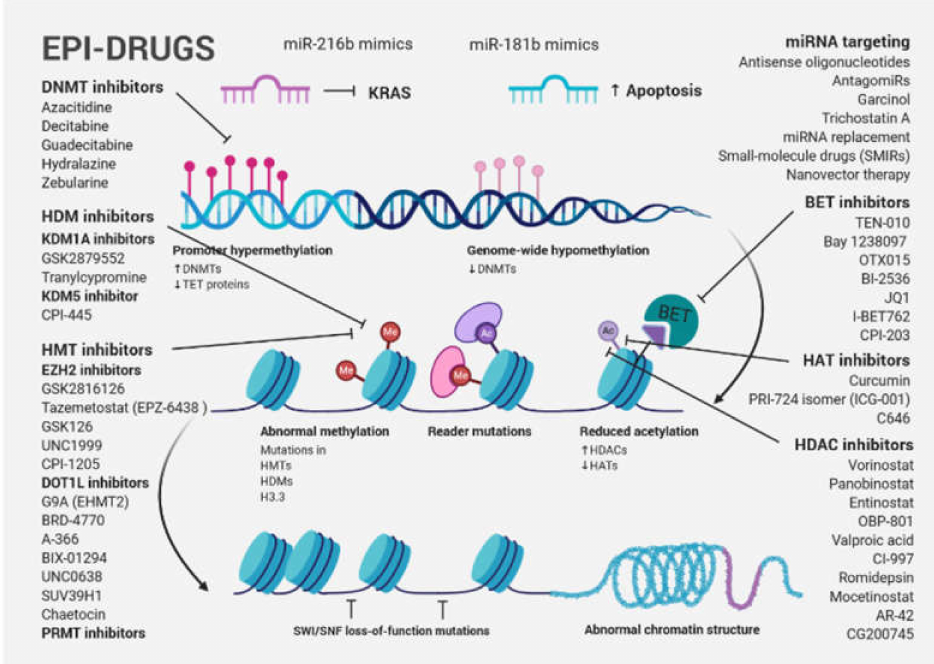
Figure 3. Schematic presentation of cancer-associated epigenetic modification abnormalities, including a brief overview of epi-drugs used in preclinical studies and clinical trials for PDAC treatment. Gene-specific hypermethylation accompanied by global DNA hypomethylation, frequent mutation of epigenetic modifiers and histone proteins, as well as abnormal histone modification patterns are typical cancer-associated epigenetic changes. A large number of the first-, second- and third-generation inhibitors, targeting epigenetic modifications, were used in preclinical studies and clinical trials. Althoughepi-drugmonotherapieswerenotsuccessful, combinationtherapytargetingdiversechromatin regulators or a biomarker-directed approach that combines a new generation of epi-drugs with traditional approaches currently represent the most promising concept for